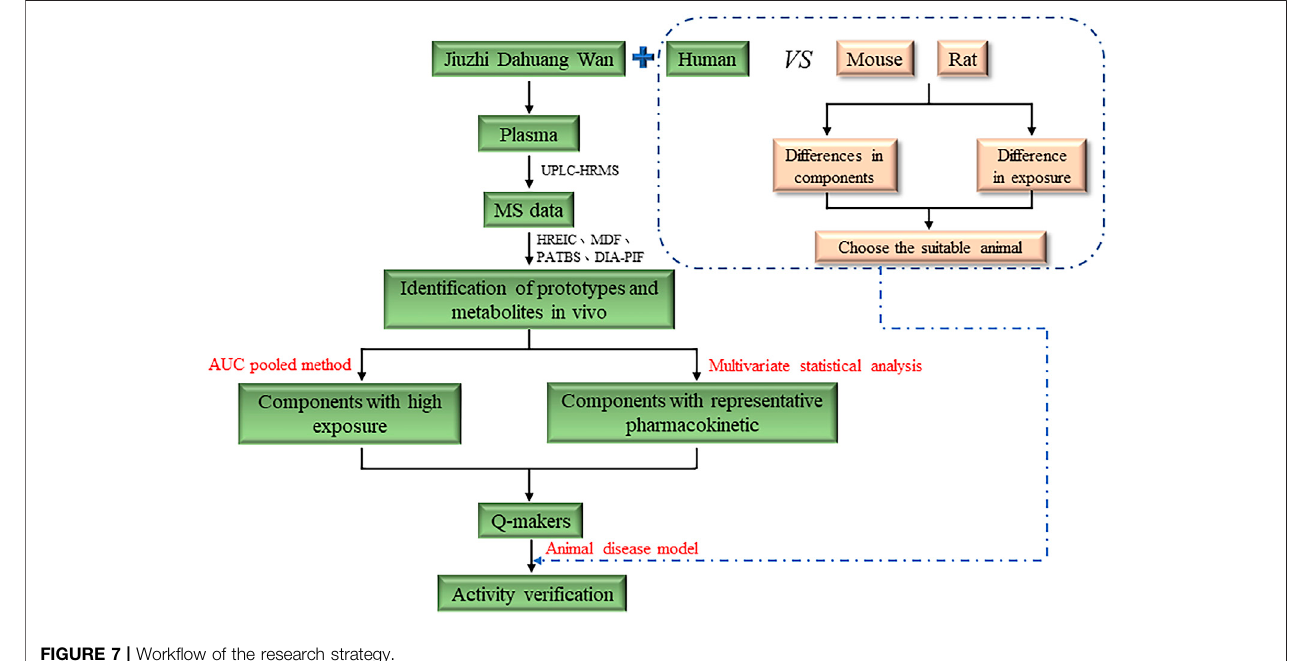
FIGURE 7 | Work fl ow of the research strategy.